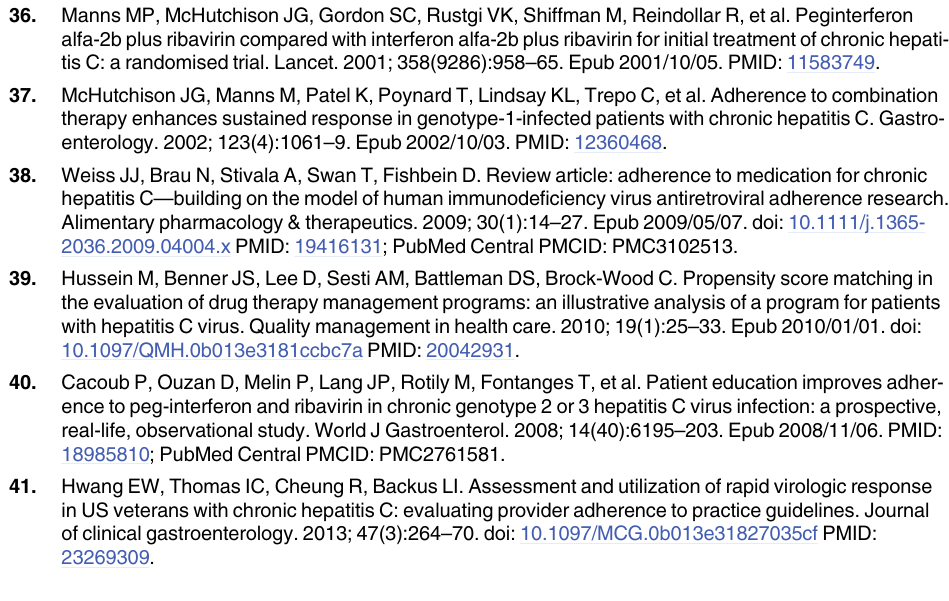
PLOS ONE | DOI:10.1371/journal.pone.0132056 July 13,